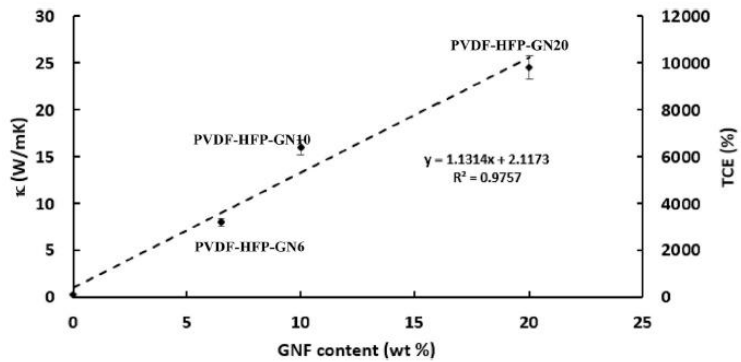
Figure 11. Thermal conductivity and thermal conductivity enhancement as a function of graphene nanoflake (GNF) wt% [101]. The experimental points correspond to the content 0, 6, 10 and 20 wt%. The parameters of the linear approximation of the experimental data and the regression value (R 2 ) are shown on the picture.